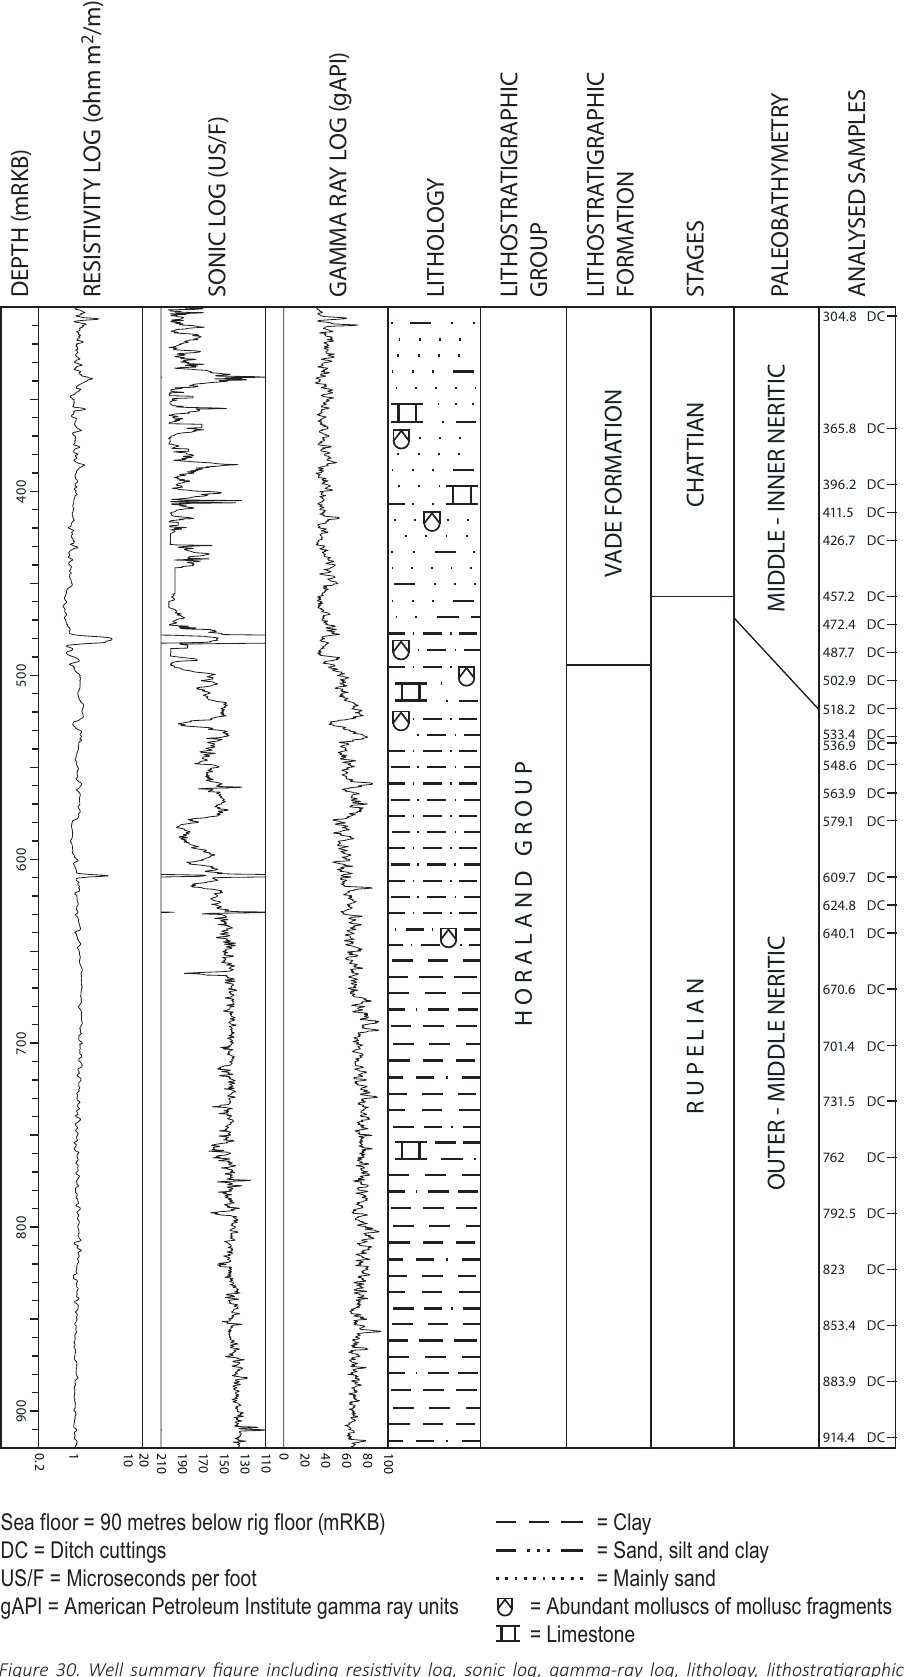
Figure 30. Well summary figure including resistivity log, sonic log, gamma-ray log, lithology, lithostratigraphic units, stages, paleobathymetry and analysed samples for the investigated sequence in well 11/10–1 (Rupelian to Chattian) including the supplementary well reference section for proximal parts of the Vade Formation (modified after Eidvin et al.,